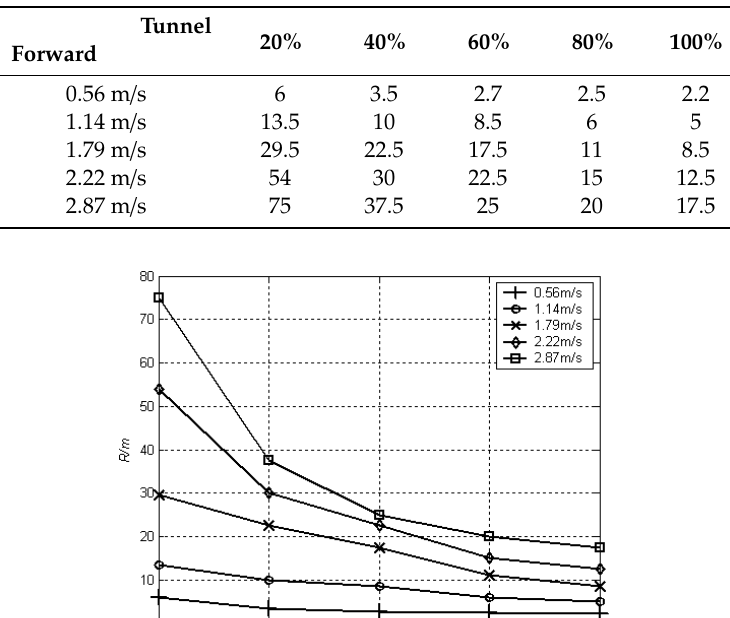
Figure 27. Turning experiment.